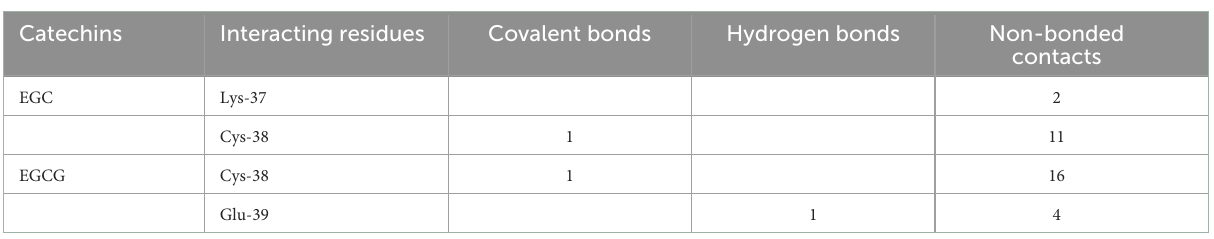
TABLE 2 Interacting residues of NF- κ B p65 for EGC and